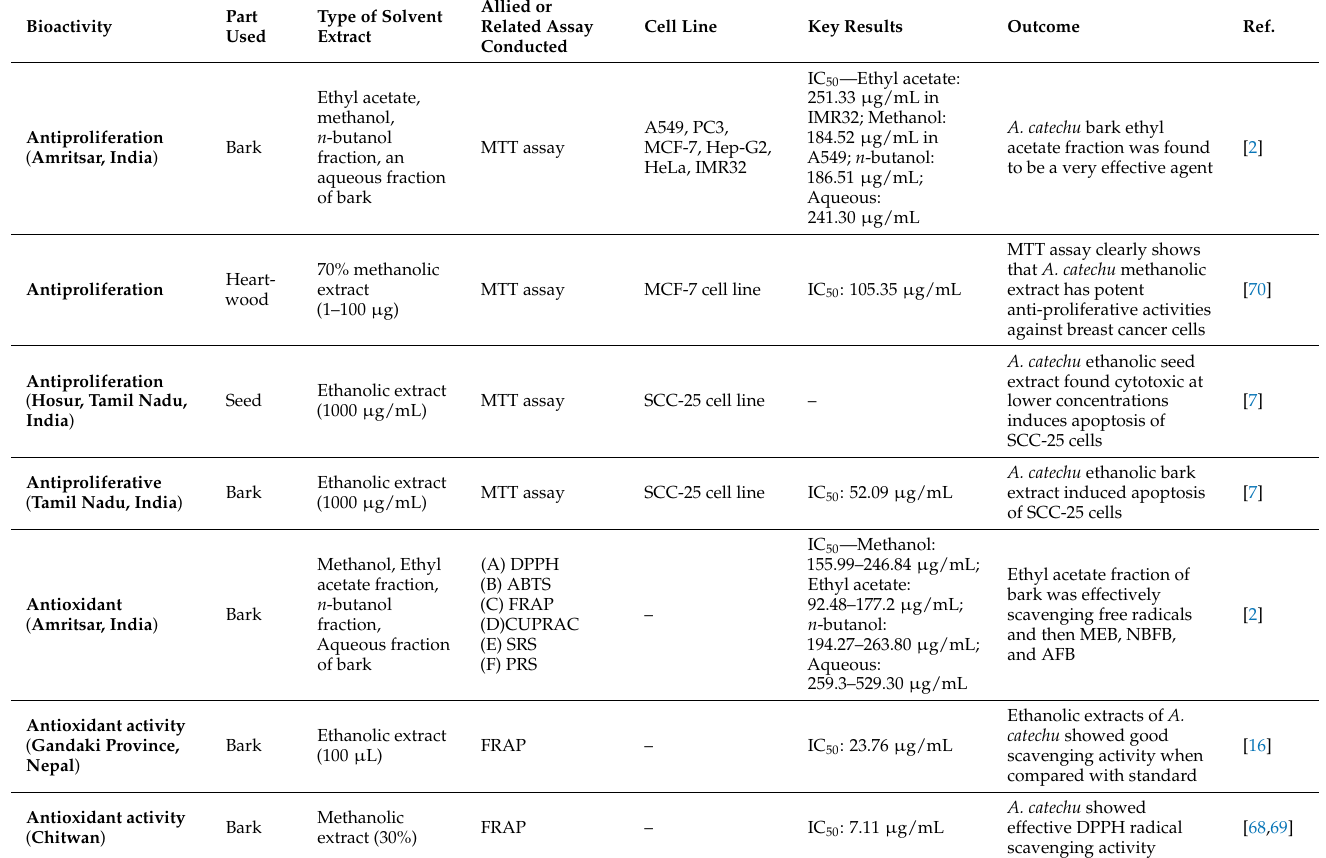
Table 5. IC 50 values of antiproliferation, antidiabetic, and antioxidant activities of different parts of Acacia catechu using different in vitro